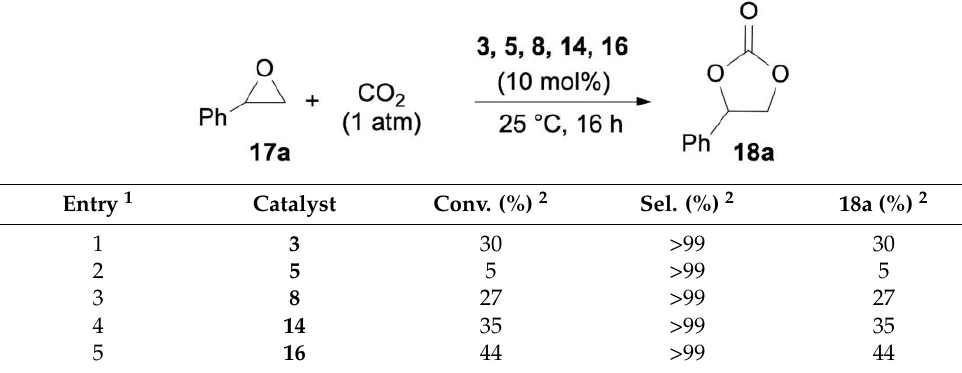
Table 2. Screening of organocatalyst 3 , 5 , 8 , 14 , and 16 activity.